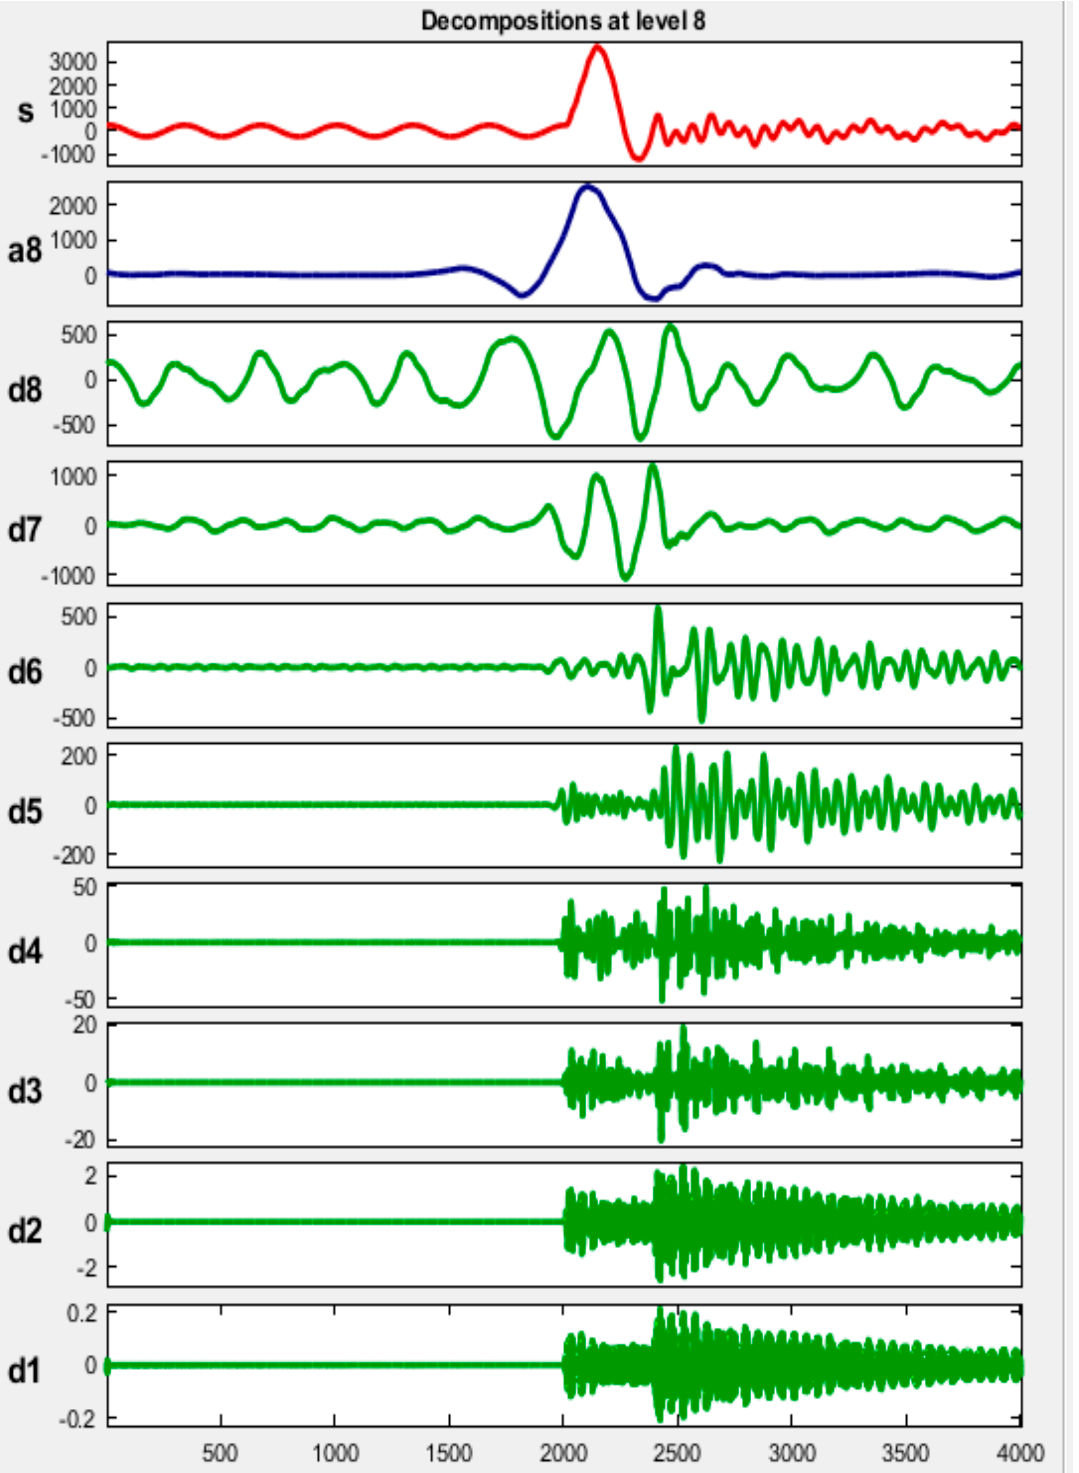
Figure 12. DWT analysis of Phase A during the LG fault without STATCOM compensation.